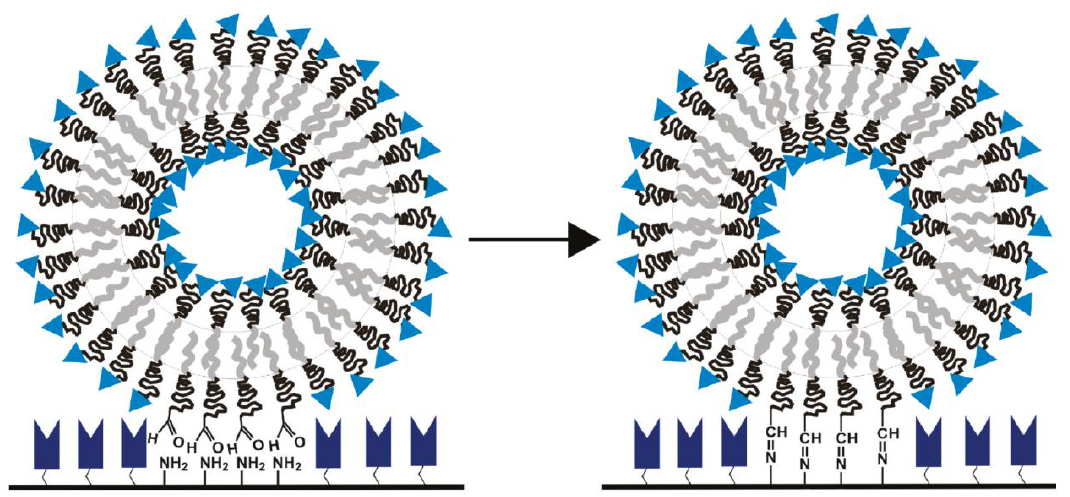
Figure 6 . Covalent immobilization of aldehyde modified polymersomes on an aminated glass surface. Reproduced by permission of the American Chemical Society